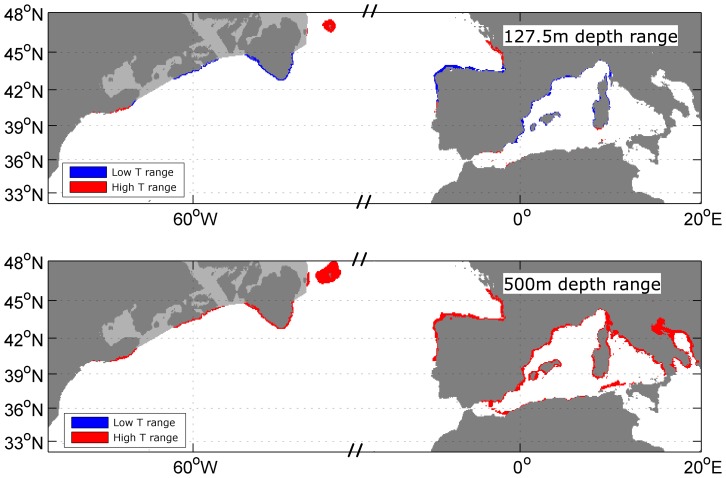
Grey seal range during LGM.Predicted grey seal habitat during LGM with drop in sea level of 123 m based solely on water depth and annual reconstructed sea surface temperature data. Top: For this estimate, grey seals inhabit a depth range between 0 m and 127.5 m and a SST range of 5.4°C to 11.7°C (blue) or 2.7°C to 12.6°C (blue and red). Bottom: For this estimate, grey seals inhabit a depth range between 0 m and 500 m and a SST range of 2.7°C to 12.6°C (red). Land is shaded dark grey and summer ice cover is light grey. Water depth contour is omitted for better clarity of the coloured areas.